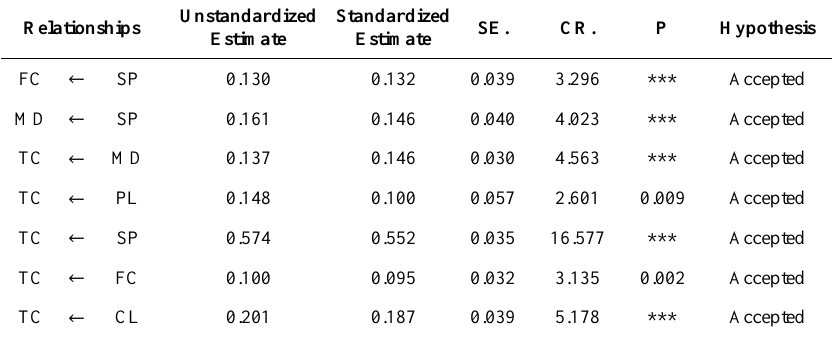
Table 3. Testing coefficients for factors affecting the green bank development Unstandardized Standardized Relationships SE. CR. P Hypothesis Estimate Estimate